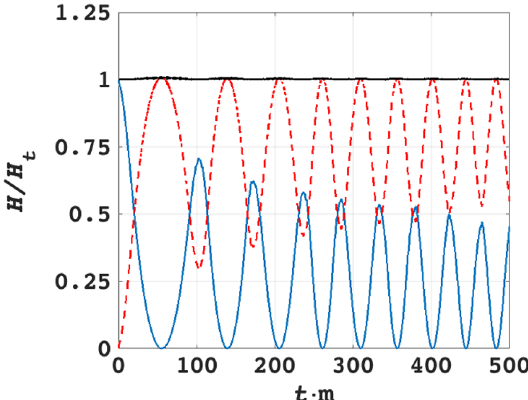
Figure 6 . Numerical evolution of different parts of the QED Hamiltonian (normalized by total Hamiltonian). The total Hamiltonian H t (black solid line) of the interacting fermion-boson system is perfectly conserved in this long-term simulation, which is a result of the preservation of the geometric structures. The energy transfer between e - e + pair plasmas and U(1) gauge field can be read out from the fermionic sector H F (red dashed line) and gauge sector H G (blue solid line) of the total Hamiltonian. The nonlinear envelopes of these curves demonstrate that the pair production experienced a process from rapid growth to saturation, where the nonlinear suppression comes from the nonpertubative field backreaction and Pauli exclusion effect. With the increase of fermion density, the plasma frequency will exhibit blue shift, which can be found as the chirp features in these Hamiltonian curves. ( e/m = 0 . 2 , ∆ x i = 0 . 05 /m, ∆ t = 0 . 5∆ x i , N t = 2 × 10 4 , N x = N y = 1 , N z = 256 , N e = 512